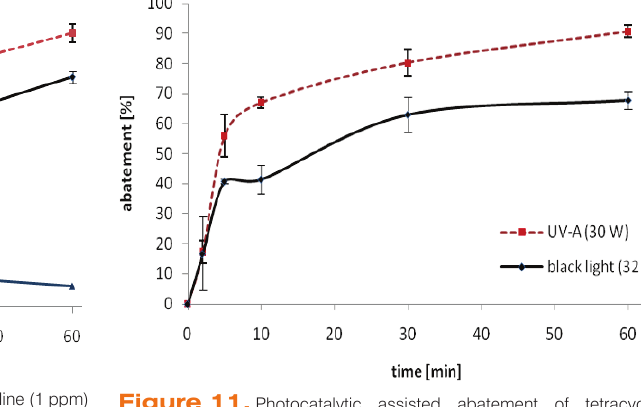
Figure 11. Photocatalytic assisted abatement of tetracycline -P25: (500 ppb) by using photocatalysts TiO 2 UV-A 30 W (above red curve), black light 32 W (below black curve).